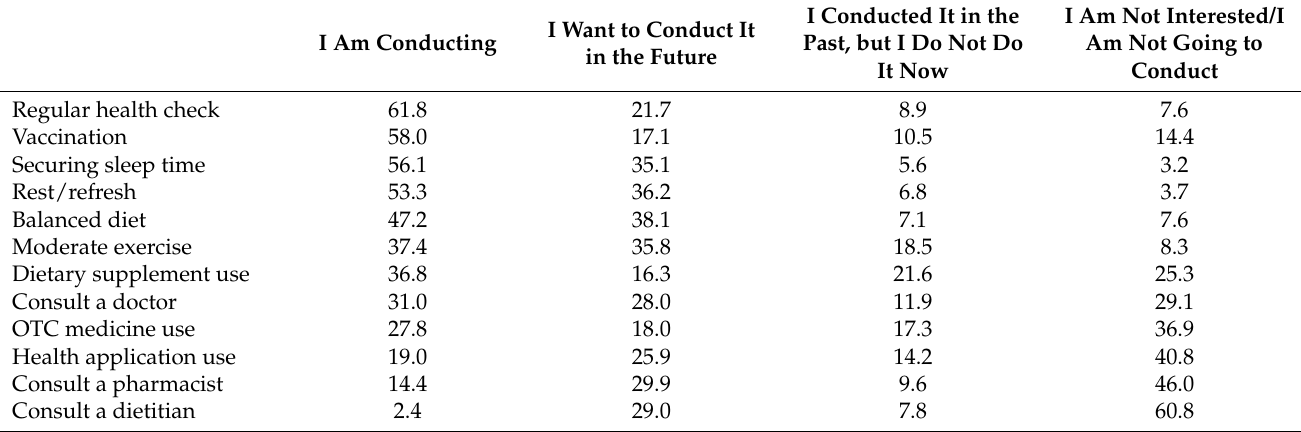
Table 4. Practical situation of self-care.